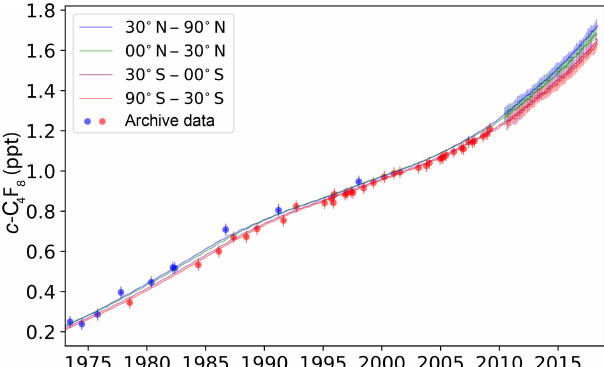
Figure 4. Historic c -C 4 F 8 mole fractions from archive samples in both hemispheres (filled circles) and pollution-free monthly mean in situ data from AGAGE background sites (MHD and THD in blue, RPB in green, SMO in purple, and CGO in green vertical bars; bar size represents variability of monthly means) are shown together with the Bristol inversion results for the four latitudinal bands rep- resented by these background sites (30–90, 0–30 ◦ N, 0–30, and 30– 90 ◦ S, solid lines of same